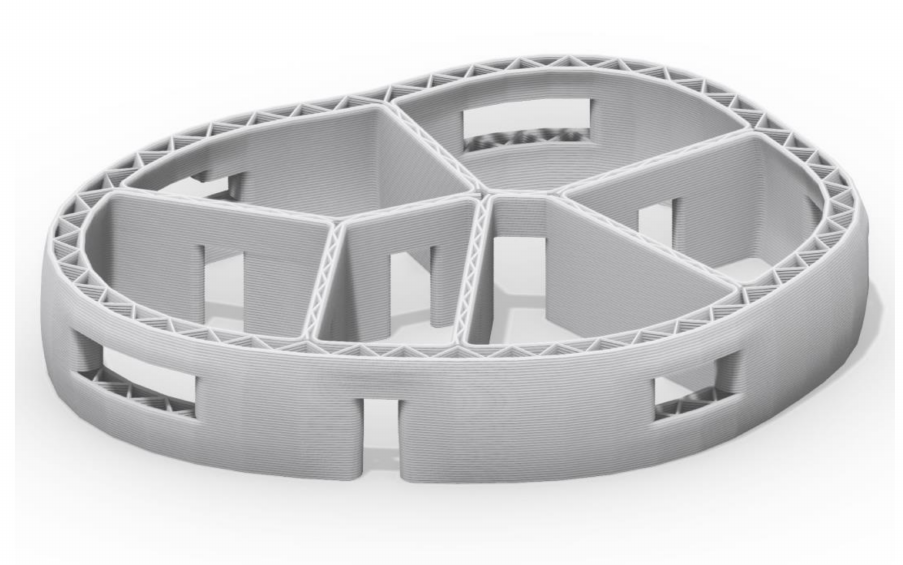
Figure 12. Model of a 3D-printed construction with identified architectural